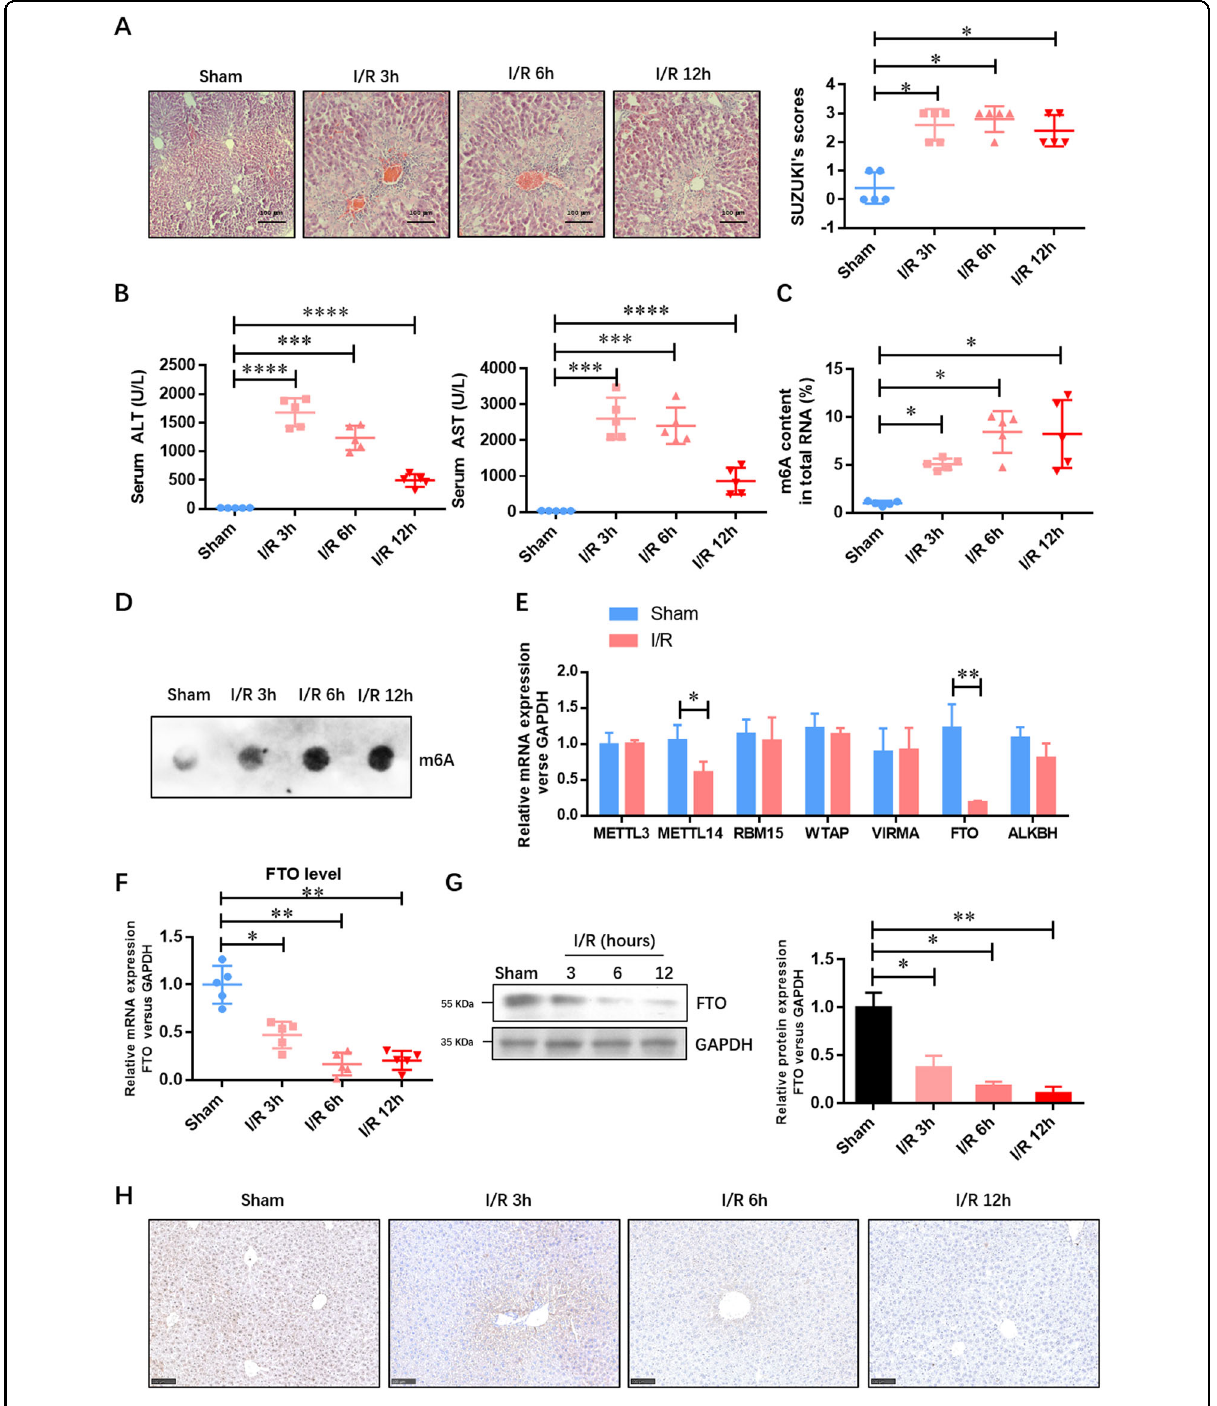
Fig. 1 The expression of m6A demethylase FTO is decreased by HIRI. A Representative histopathologic images of liver sections harvested at 24 h after reperfusion (H&E staining; scale bars, 100 μ m). The damage degree was graded using Suzuki criteria. B Blood samples were collected to determine the ALT and AST levels (U/L). C The total level of methylated RNA (m6A) in hepatic tissues was detected by EpiQuik m6A RNA Methylation Quanti fi cation Kit. D The total level of methylated RNA (m6A) in hepatic tissues was detected by dot blotting analysis. E The expressions of major m6A methyltransferases (METTL3, METTL14, RBM15, WTAP, and VIRMA) and demethylases (FTO and ALKBH5) at the mRNA level were examined by qRT-PCR. F The expression of FTO at the mRNA level was examined by qRT-PCR. G The expression of FTO at the protein level was veri fi ed by Western blotting analysis. H The expression of FTO at the protein level was veri fi ed by IHC. N = 5; * P < 0.05 and ** P < 0.01, *** P < 0.001 vs. sham